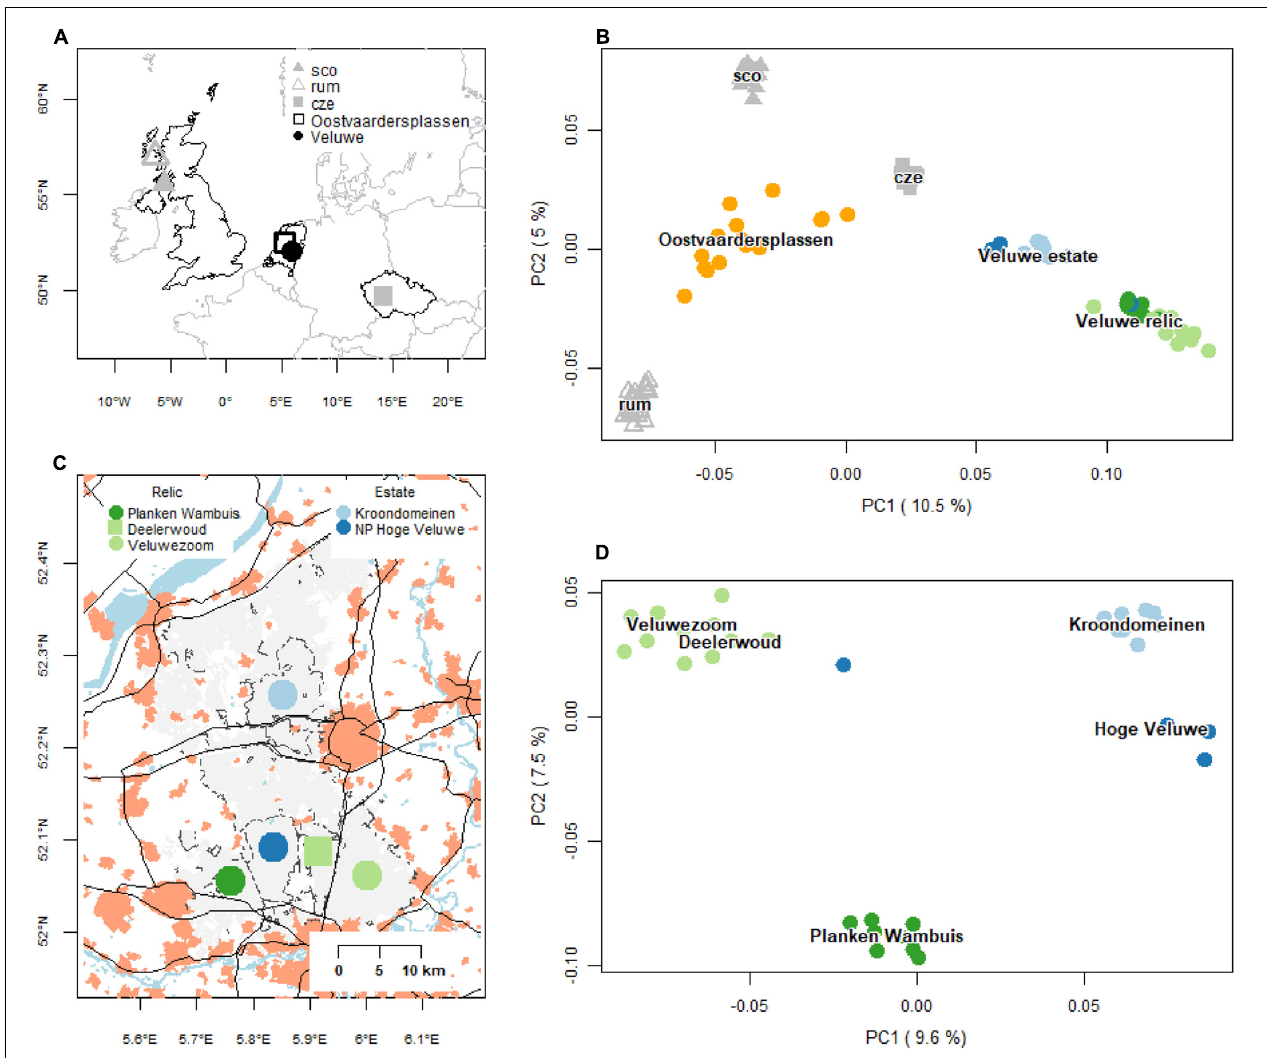
FIGURE 2 | Geography and genetic structure of red deer samples. (A) Geographic distribution of the red deer populations of Netherlands, and reference populations of Czechia and Scotland (mainland and Isle of Rum). Oostvaardersplassen is an allochthonous rewilding population, established in the early 1990s. Kroondomeinen and Hoge Veluwe are allochthonous Veluwe estate populations, established the early 1900s. Planken Wambuis (Southwest Veluwe) and Veluwezoom/Deelerwoud (Southeast Veluwe) are relic autochthonous populations. Abbreviations of the reference populations are: sco, mainland Scotland; rum, Isle of Rum; cze, Czechia. (B) First two axis of a PCoA of pairwise Hamming genetic distances of all populations (based on a maximum of 25 deer per population). Labels are positioned at the median ordination axis scores. (C) Geographic distribution of subpopulations of the focal populations in the Veluwe. Based on demographic history, red deer populations of the Veluwe can be distinguished as either relic populations, i.e., continuously present (color: green) and estate populations, which were founded at the beginning of the 20th century and are fenced (color: blue). Filled light gray areas are forests and heaths, light red areas cities and towns, black lines roads and black dashed lines fences. (D) PCoA biplot of the focal Veluwe populations. Labels are positioned at the median ordination